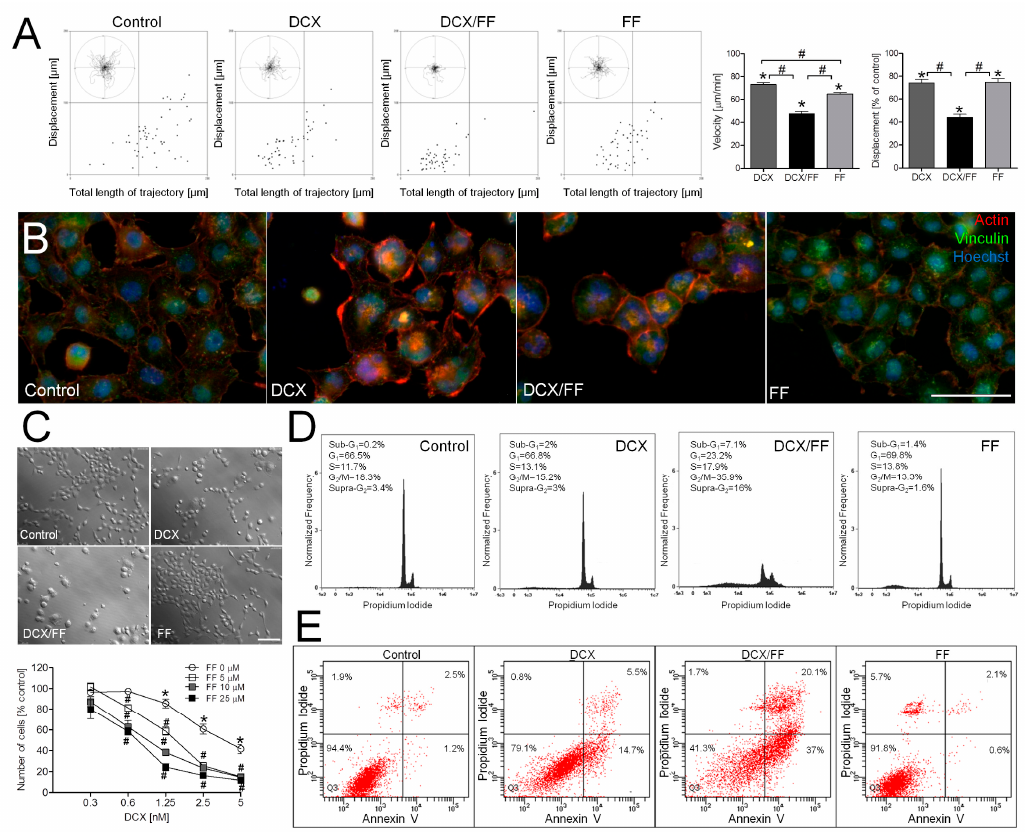
Figure 1. Additive effects of fenofibrate (FF) and docetaxel (DCX) on the viability and invasive potential of naïve DU145 cells. ( A ) Naïve DU145 cells were incubated in the presence of DCX (2.5 nM) and/or FF (25 µ M) and their motility was estimated immediately after drug administration. Cell trajectories are depicted as circular diagrams (axis scale in µ m) drawn with the initial point of each trajectory placed at the origin of the plot (registered for 6 h; N > 50). Dot-plots and column charts show movement parameters at the single cell and population level, respectively (plotted as % of control). ( B ) Intracellular localization of actin (red) and vinculin (green) were visualized by immunofluorescence in DU145 cells incubated in the presence of DCX/FF (2.5 nM/25 µ M) for 48 h. ( C ) DU145 cells were cultivated in the presence of DCX (0.3–5 nM) and/or FF (5–25 µ M). Their morphology (upper panel; 2.5 nM DCX/25 µ M FF) and proliferation (lower panel; calculated as % of control) were estimated after 48 h. ( D , E ) The effect of the long-term DCX/FF (2.5 nM/25 µ M) treatment on the viability of DU145 cells was estimated with fluorescence-activated cell sorting (FACS)-assisted DNA content (after 48 h; D ) and annexinV/PI assay (after 72 h; E ). DNA histograms and compensated dot-plots comprise 30,000/50,000 events, classified based on their bright field ratios and/or nuclear contrast. Statistical significance was analyzed with the non-parametric Mann-Whitney ( A ; vs. non-treated control (* p ≤ 0.05) or vs. controls indicated by the backets; # p ≤ 0.05); or by t-Student test ( C ; vs. non-treated control (* p ≤ 0.05) or vs. DCX-treated variant (0 µ M FF; # p ≤ 0.05). Error bars represent standard error of the mean (SEM). Scale bar: 50 µ m ( B ) and 100 µ m ( C ). Data are representative of at least three independent experiments (N > 3). Note that FF increases the sensitivity of DU145 cells to